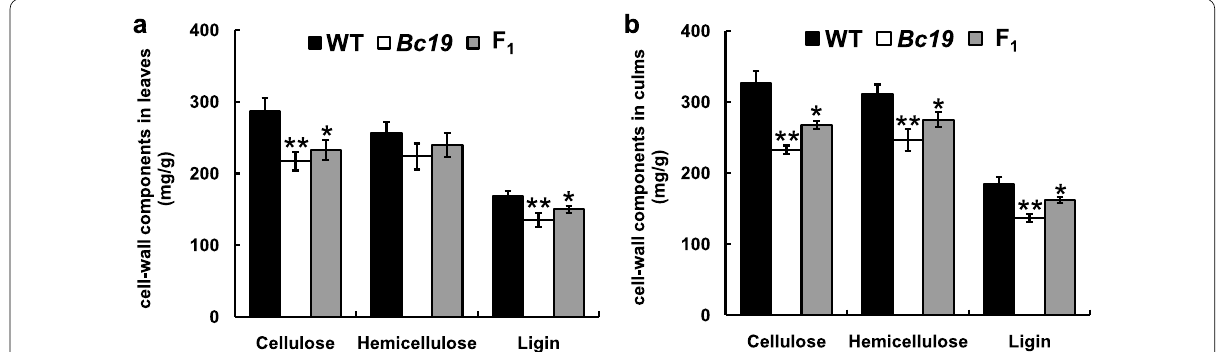
Fig. 3 Contents of cellulose, hemicellulose and lignin in cell walls from leaves ( a ) and culms ( b ) of Bc19 , the wild type (WT) and F 1 plants, in mg g fresh weight − 1 . F 1 : Obtained from Bc19 crossing with WT. Double and single Asterisks indicate statistically significant differences compared to the wild type at p < 0.01 and p < 0.05, respectively